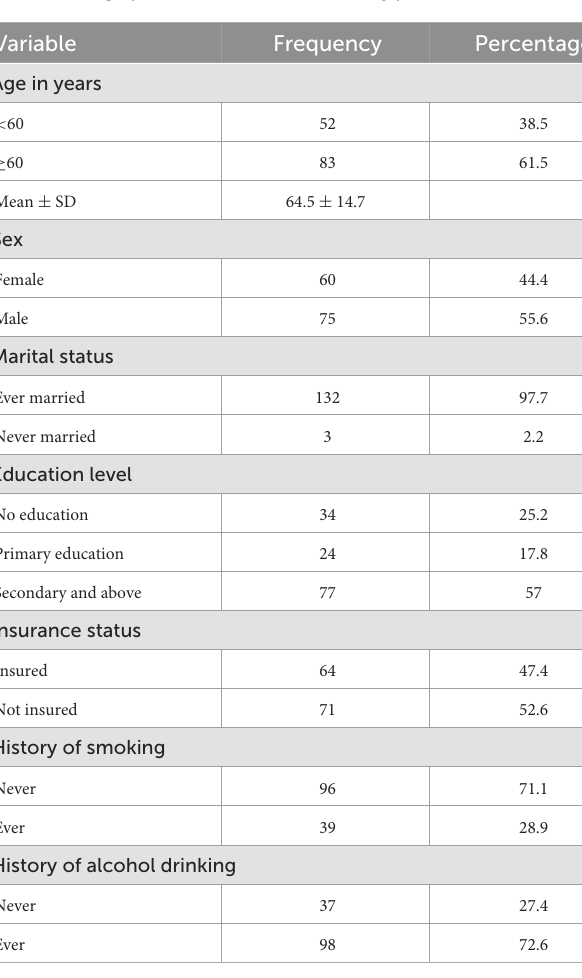
TABLE 1 Demographic characteristics of the study patients.